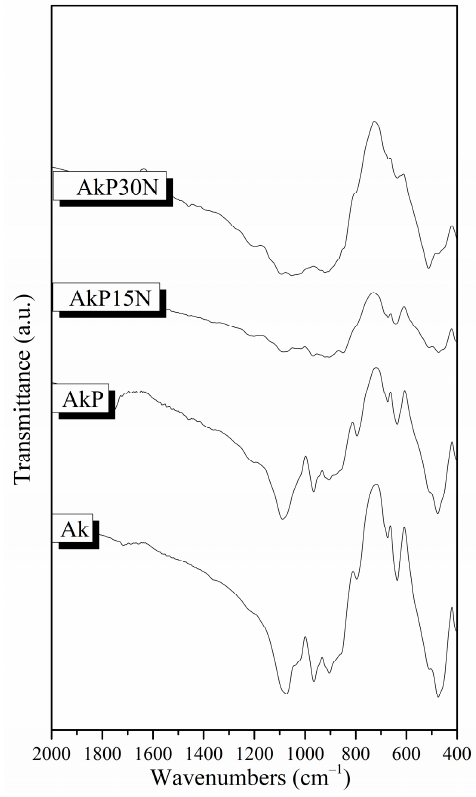
Figure 12 . FTIR spectra of synthesized scaffolds before immersion in SBF. Figure 12. FTIR spectra of synthesized scaffolds before immersion in